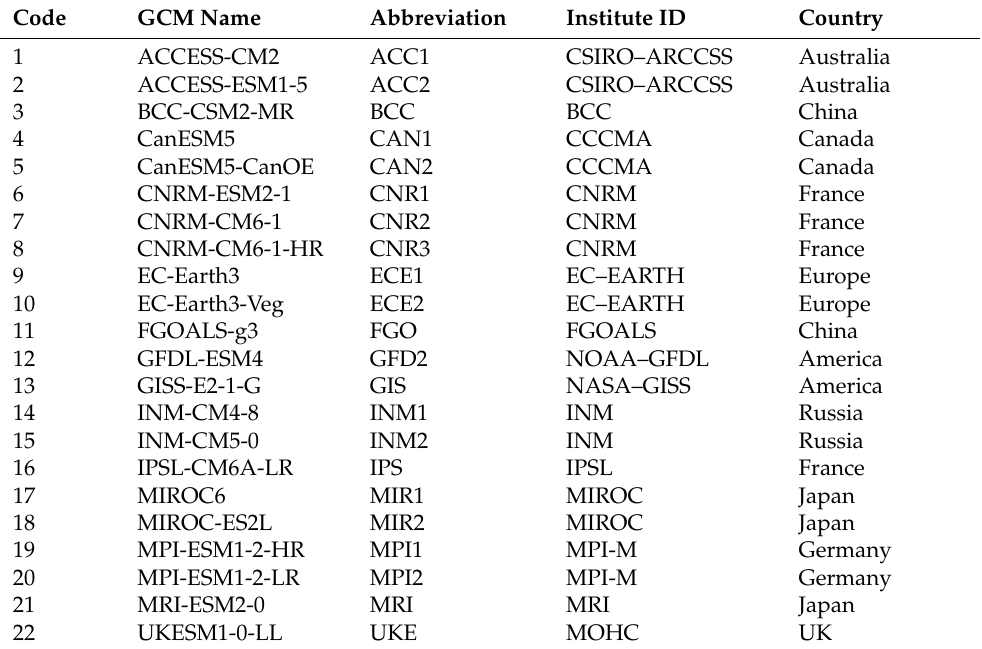
Table 1. List of the 22 GCMs for future climate projections used in the